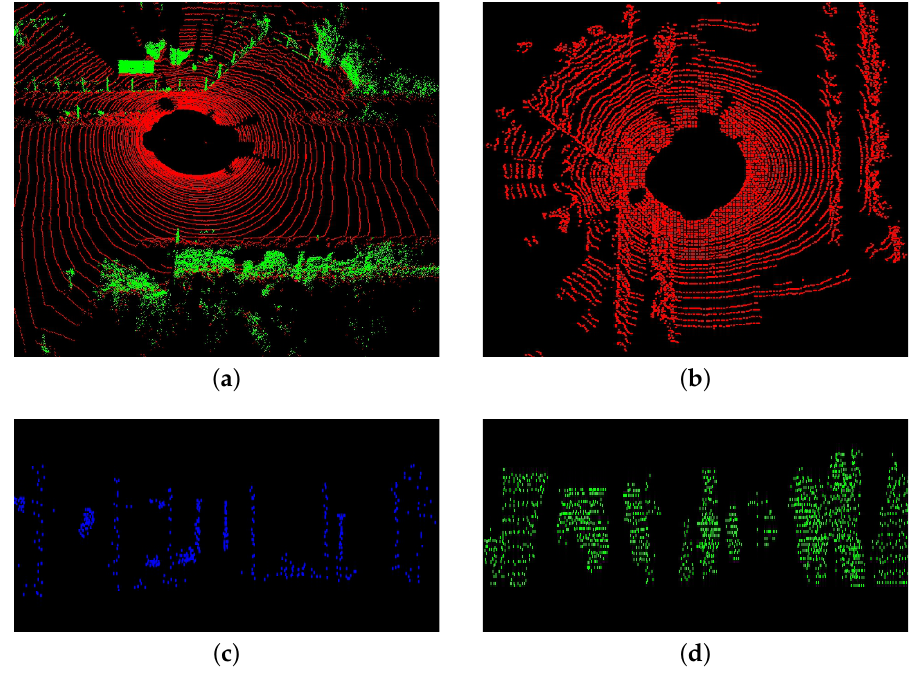
Figure 2. ( a ) is the result of ground segmentation. In ( a ), the red points are labeled as ground points and the green points are labeled as non-ground points. ( b – d ) are the ground planar features, non-ground edge features and non-ground planar